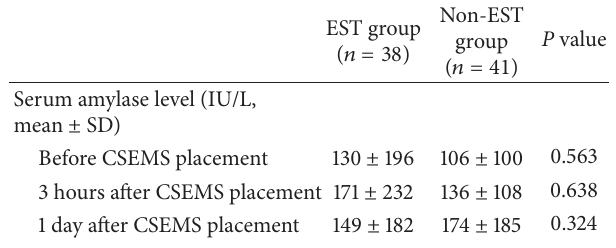
Table 2: Comparison of complications between the EST and non- EST